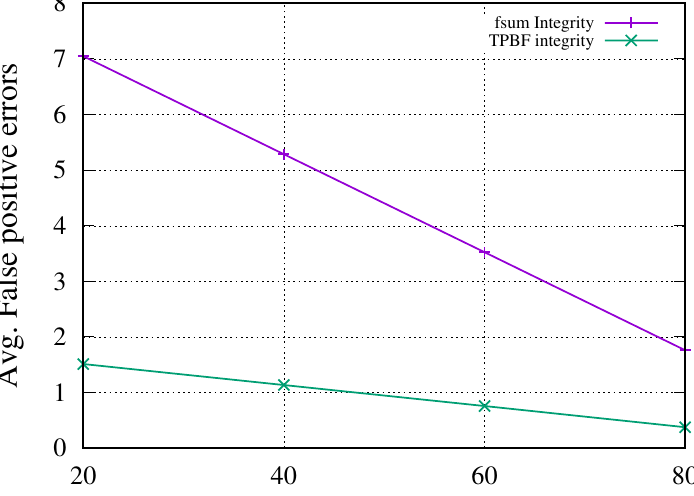
Figure 13. False-positive errors comparison of fsum and